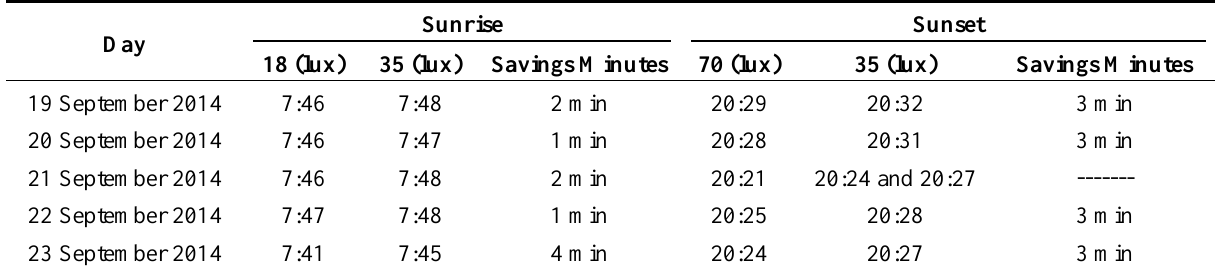
Table 11. Time when the natural light reached a certain